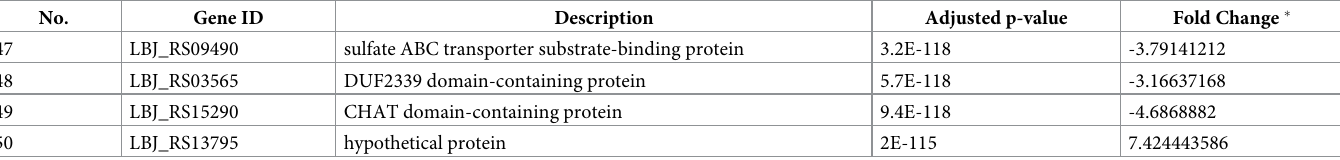
29˚C include ligB (adj. p-value = 6.8E-8, FC = -3.9), lipL45 (LBJ_RS07310/